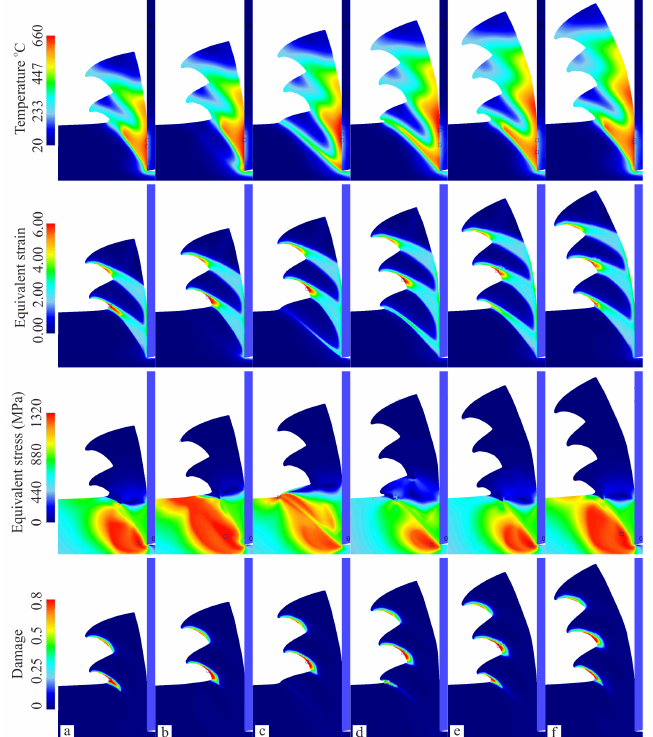
Figure 6. Temperature, equivalent strain ¯ (cid:101) , equivalent stress ¯ σ (von Mises) and damage contours at different stages ( a – f ) of the chip segment formation ( v = 200 m/min, feed = 0.10 mm/rev, rake angle γ = 0 ◦ ; NCL damage criterion CDV = 0.8). Simulations using a minimum mesh size of h min ≈ 0.4–1.6 µ